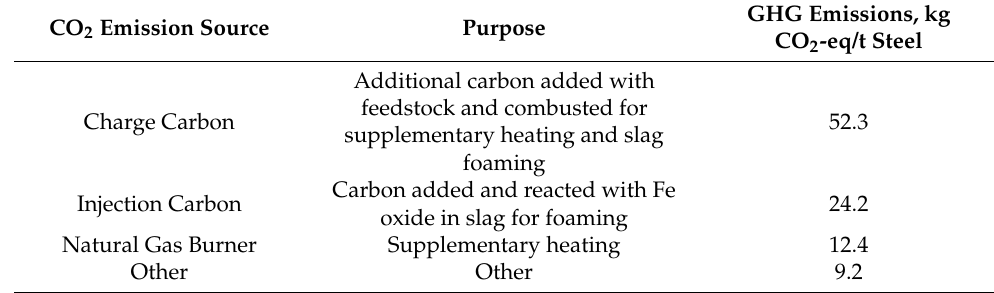
Table 1. Direct GHG emissions of EAF steelmaking (values taken from a study by Thomson et al.